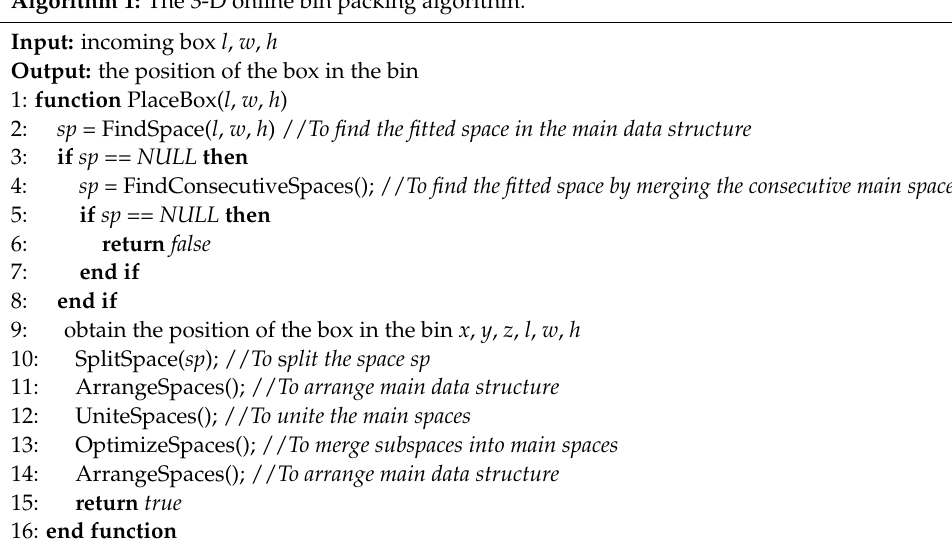
Figure 4. Flowchart of the developed online 3-D bin packing. Algorithm 1: The 3-D online bin packing algorithm.